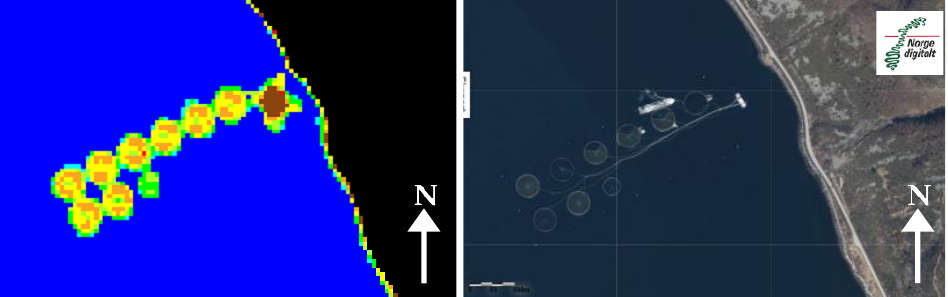
Figure 16. Salmon farm detected as intertidal zone ( left ) and visible in aerial mosaics (© norgeibilder.no, Kartverket, Norge digitalt, Terratec AS).